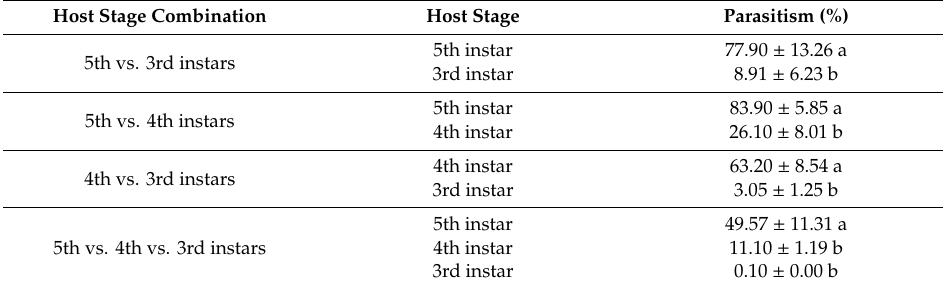
Table 1. The parasitism of female Tamarixia radiata when offered the same ratio of different citri instars nymphs for 24 h under laboratory Diaphorina citri instars nymphs for 24 h under laboratory conditions.